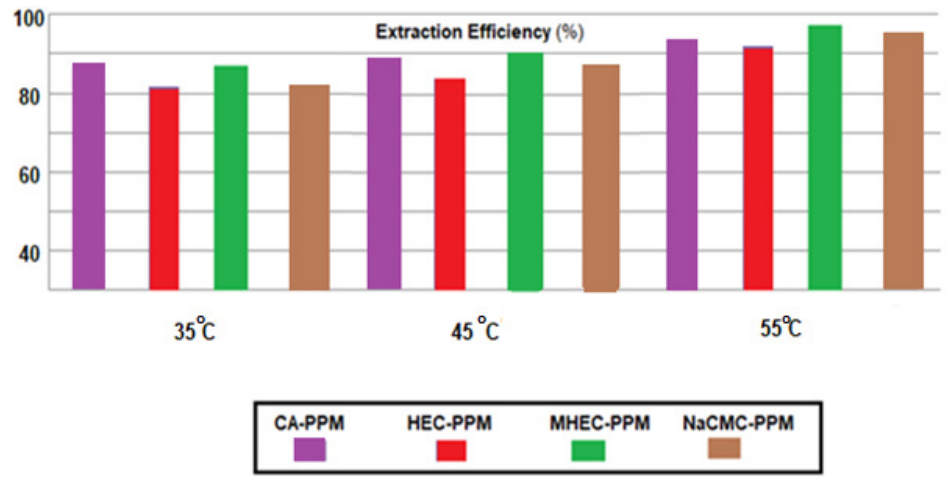
19 of 25 Figure 17. The phenylalanine extraction efficiency EE (%) variation versus the pH of the source phase (SP) for the prepared membranes. Determination of the efficiency of extraction of the amino acids from source solutions of pH = 12, at temperatures of 35, 45 and 55 °C, shows that the separation efficiency grows with increasing temperature for all four types of membranes (Figure 18). A more pro-